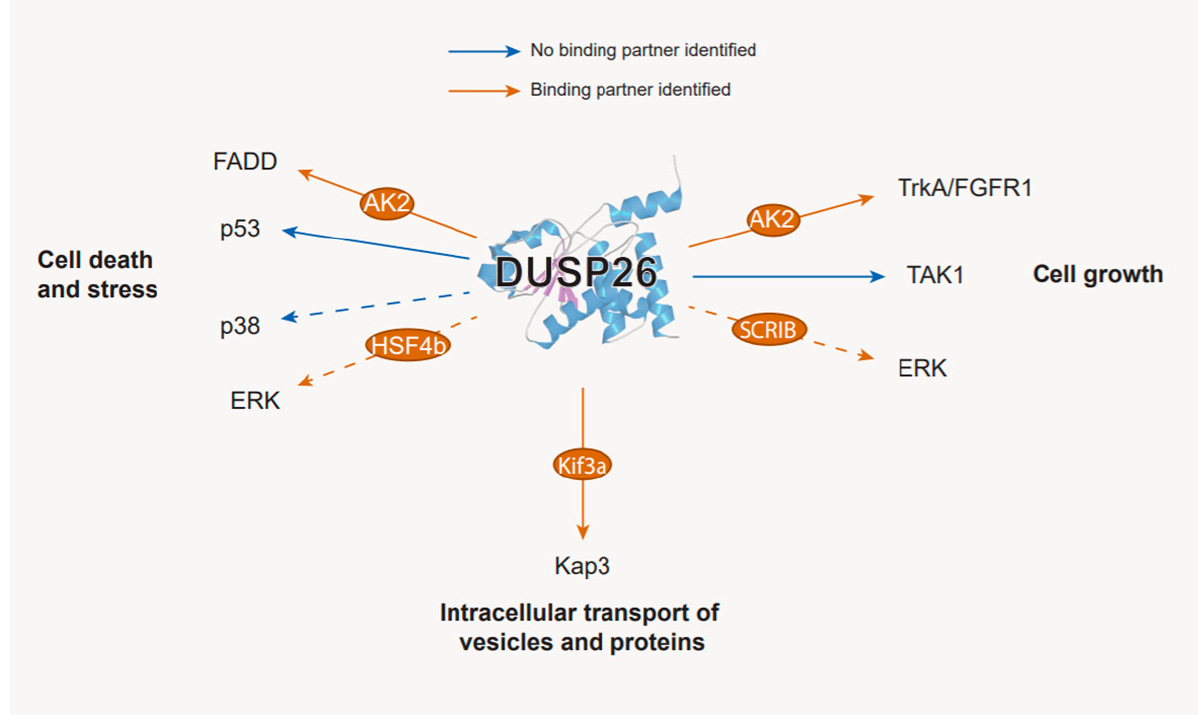
Figure 3. The substrates and binding partners of DUSP26. Displayed at the end of each arrow are DUSP26 targets that have been validated either in vitro or in vivo. Binding partners are depicted in orange circles along the arrows; substrates where no binding partner has been identified are depicted with blue arrows; substrates which require or are enhanced by a binding partner are depicted with orange arrows. Dashed arrows indicate substrates where the interaction has not been validated experimentally. See the text for further details.